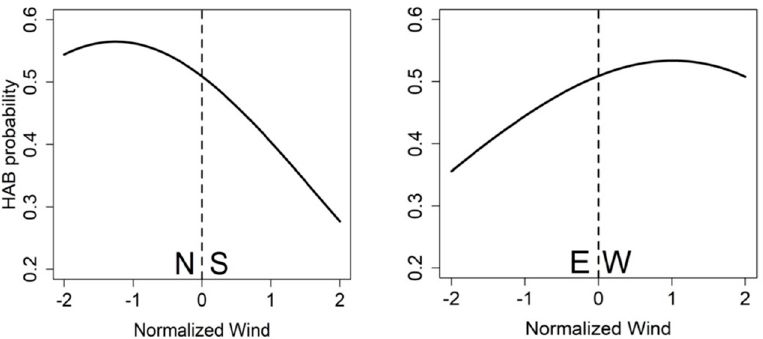
Figure 6. Probability of Karenia brevis as a function of wind speed and direction, obtained from the sensitivity analysis using the RVM.